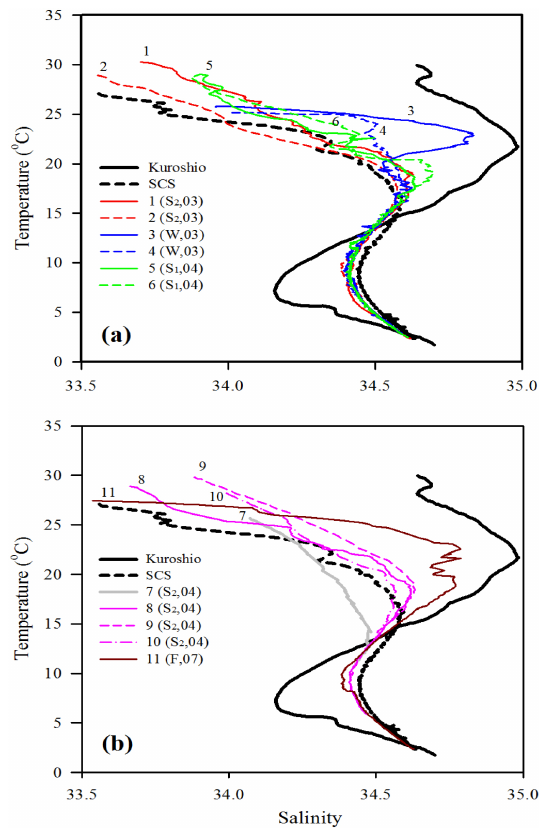
Figure 3. T – S plots for comparing water-column characteristics among stations 1–6 (a) and stations 7–11 (b) . Kuroshio and SCS indicate the typical T – S features of Kuroshio and South China Sea waters, respectively. The Kuroshio and SCS waters are typical wa- ters collected from the West Philippine Sea and central SCS, respec- tively. Note that the data of sampling season (S1: spring; S2: sum- mer; F: fall; W: winter) and year (e.g., 04 for 2004) are included for each sampling